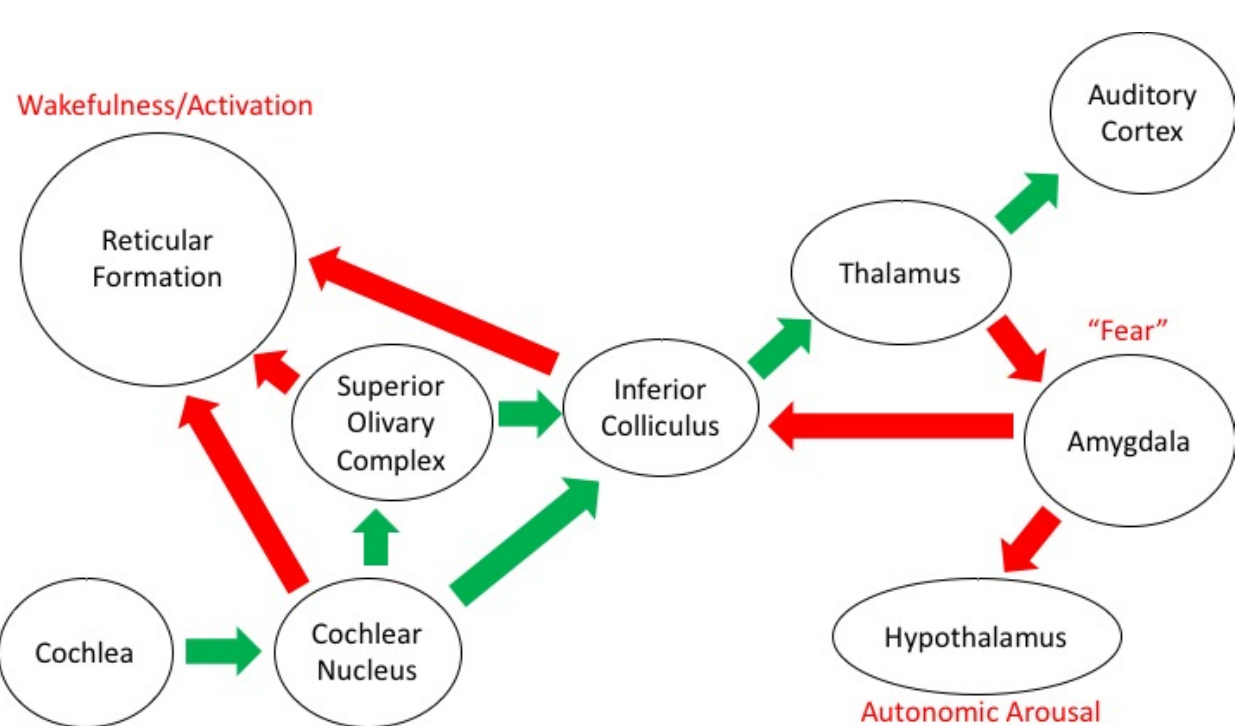
Figure 1. Schematic diagram of the auditory projections in the brain. The classical auditory pathway that conveys information about sound from the ear to the cortex is shown in green, the other projections to structures related to emotion and arousal are shown in red (Figure reproduced without modification from [43]. (Copyright © 2019 Reybrouck, Podlipniak and Welch. Creative Commons Attribution License (CC BY)).